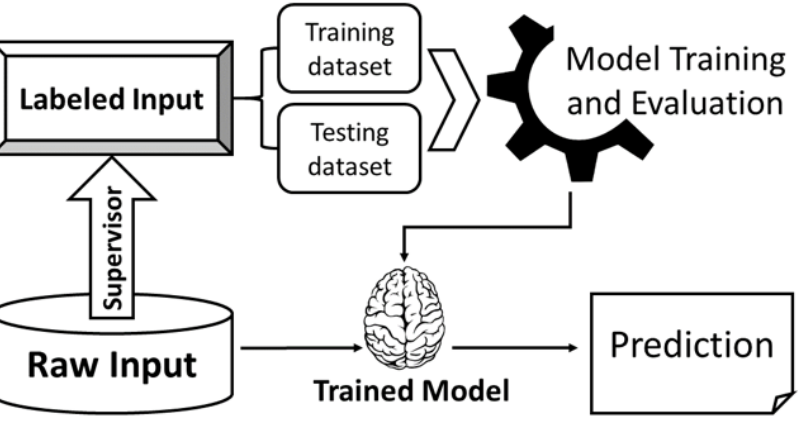
Figure 1. Workflow of supervised learning.